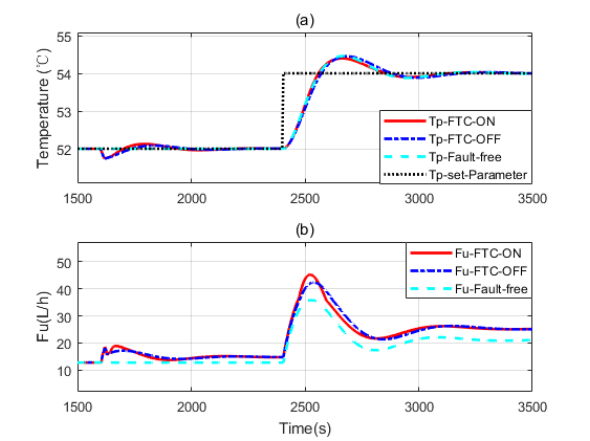
Figure 9. ( a , b ) The simulation considering a faulty parameter dropping to 65% of its nominal value.